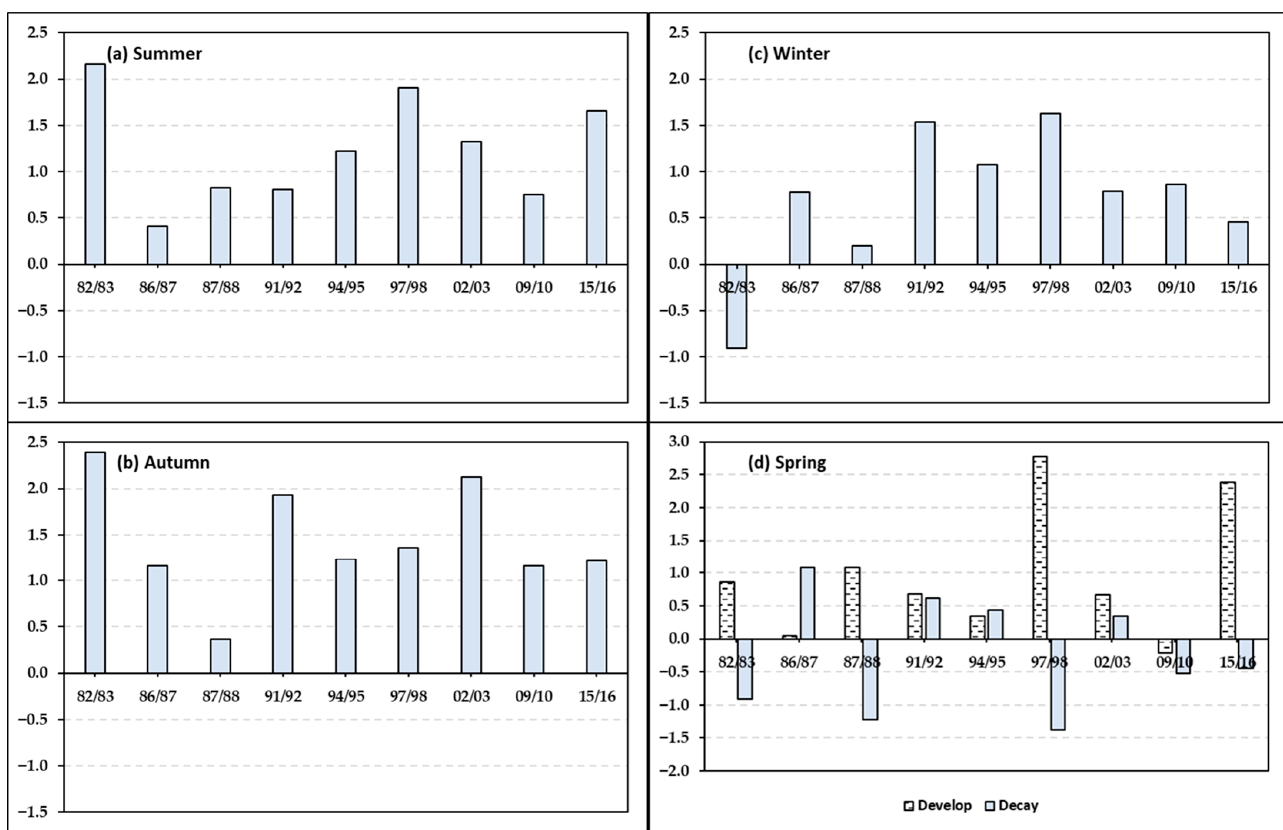
Figure 9. The average of westerly wind anomalies (N/m2) in the Western Pacific (15°S to 15°N; 120°E to 180 ˚ E); JJA ( a ), SON ( b ), DJF ( c ), and MAM ( d ). In ( d ), dashed stripes bar represents the first year of EN and blue bar represents the second year of EN.